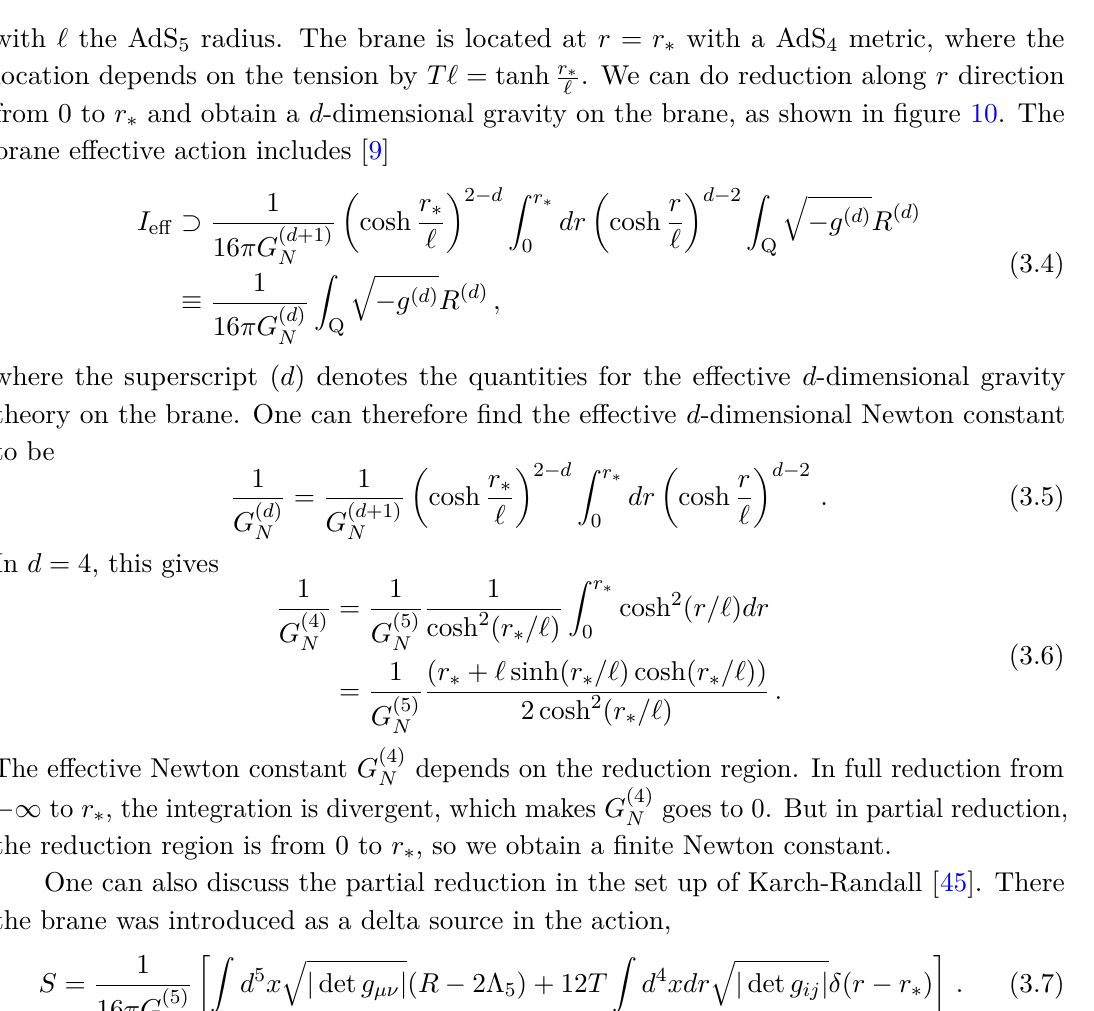
Figure 10 . The illustration of partial reduction(left) and full reduction(right) of a time slice of AdS 5 . The red dashed line represents the zero tension brane and red solid line is the positive tension